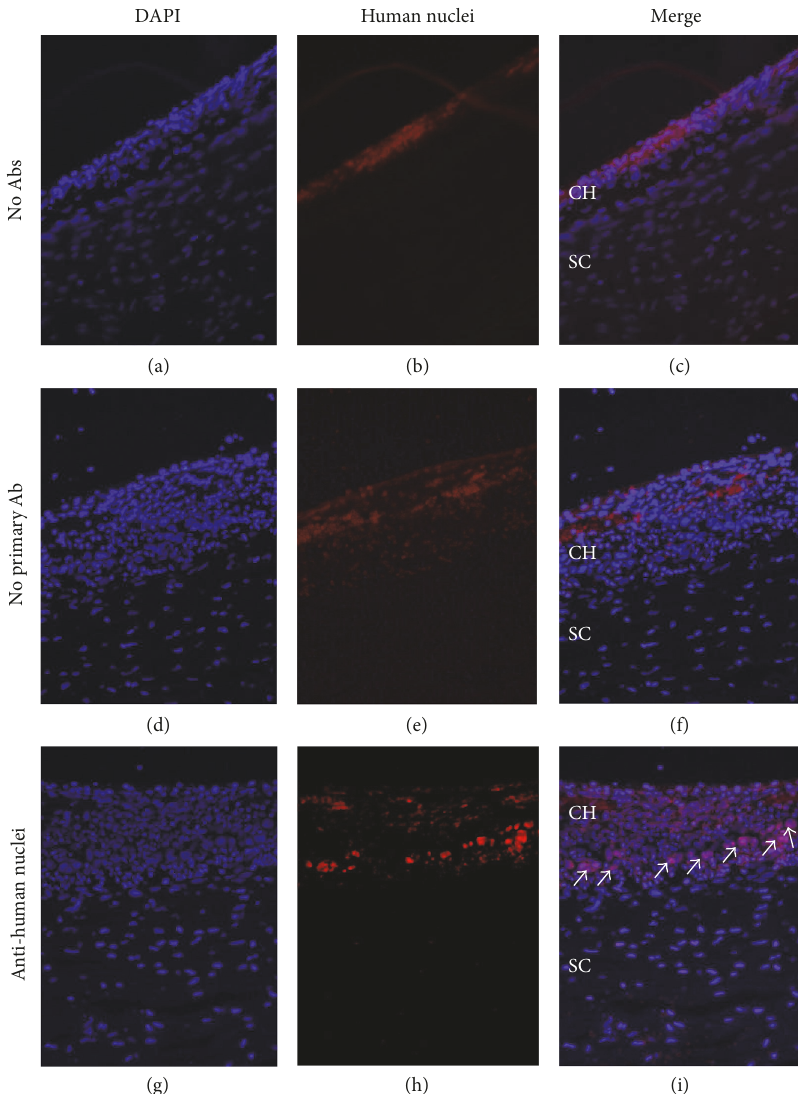
Figure 1: Identi fi cation of transplanted hBMSCs in the EVSC compartment 2 hours following transplantation. Frozen sections of rabbit eyes removed 2 hours following transplantation of nonlabeled hBMSCs were stained with anti-human nuclei antibody (red, (h) and (i)) to identify the transplanted human cells. White arrows highlight transplanted cell. Sections counterstained with DAPI only (no antibodies, (a), (b), and (c)) or incubated with secondary antibody only (d), (e), and (f) are presented as control. All sections were counterstained with DAPI (blue). CH: choroid; SC: sclera; Ab: antibody. Scale bar 100 μ